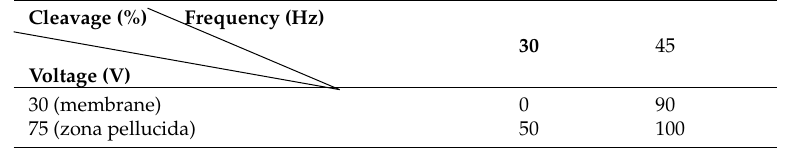
Figure 8. Comparison between the lateral vibrations of different frequencies of driving signals. Table 2. Set of experimental results on cells with different parameters for second injector.